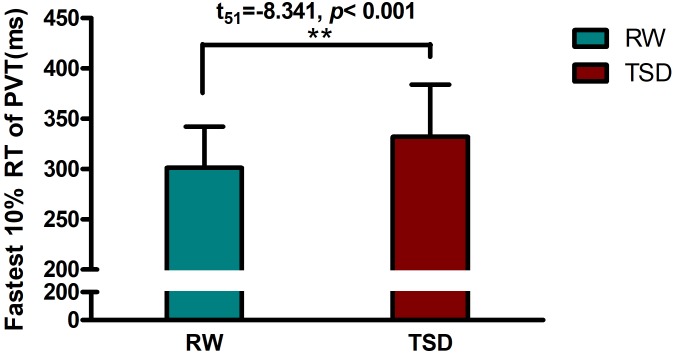
Increased fastest 10% reaction times of PVT between the RW and TSD conditions. The error bars represent the standard deviation from the mean; ∗∗p < 0.01 paired t-test. PVT, psychomotor vigilance test; TSD, total sleep deprivation; RW, rested wakefulness; fastest 10% reaction times, the mean of the 10% fastest trials for the PVT.